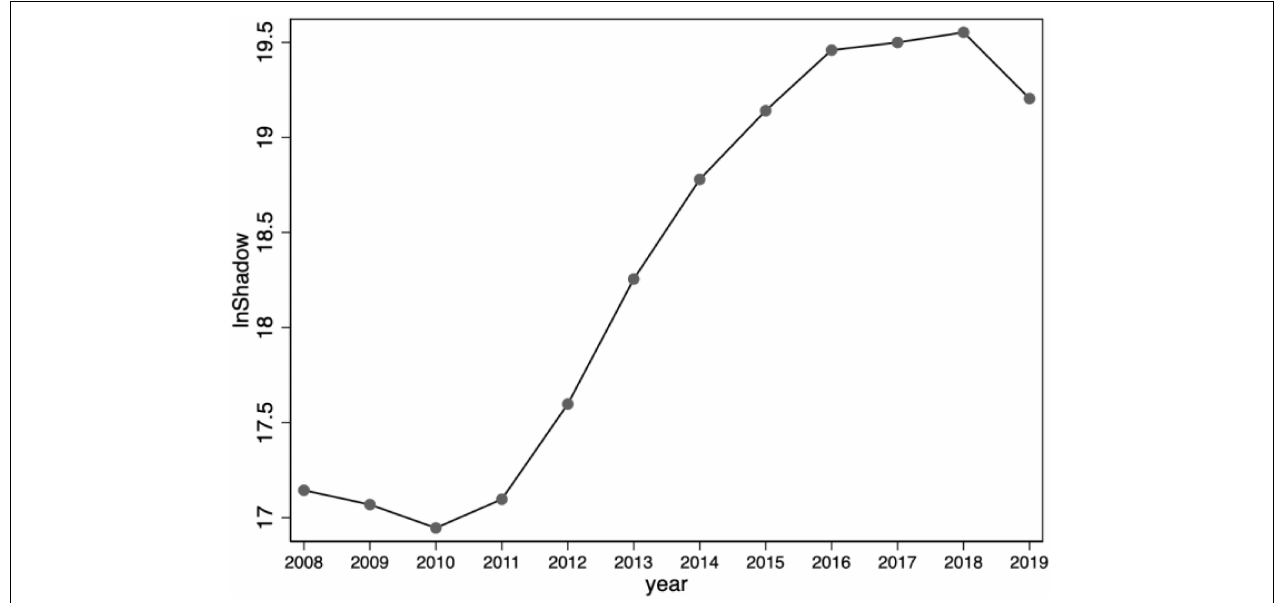
FIGURE 1 | Trends in shadow banking business of non-financial enterprises,